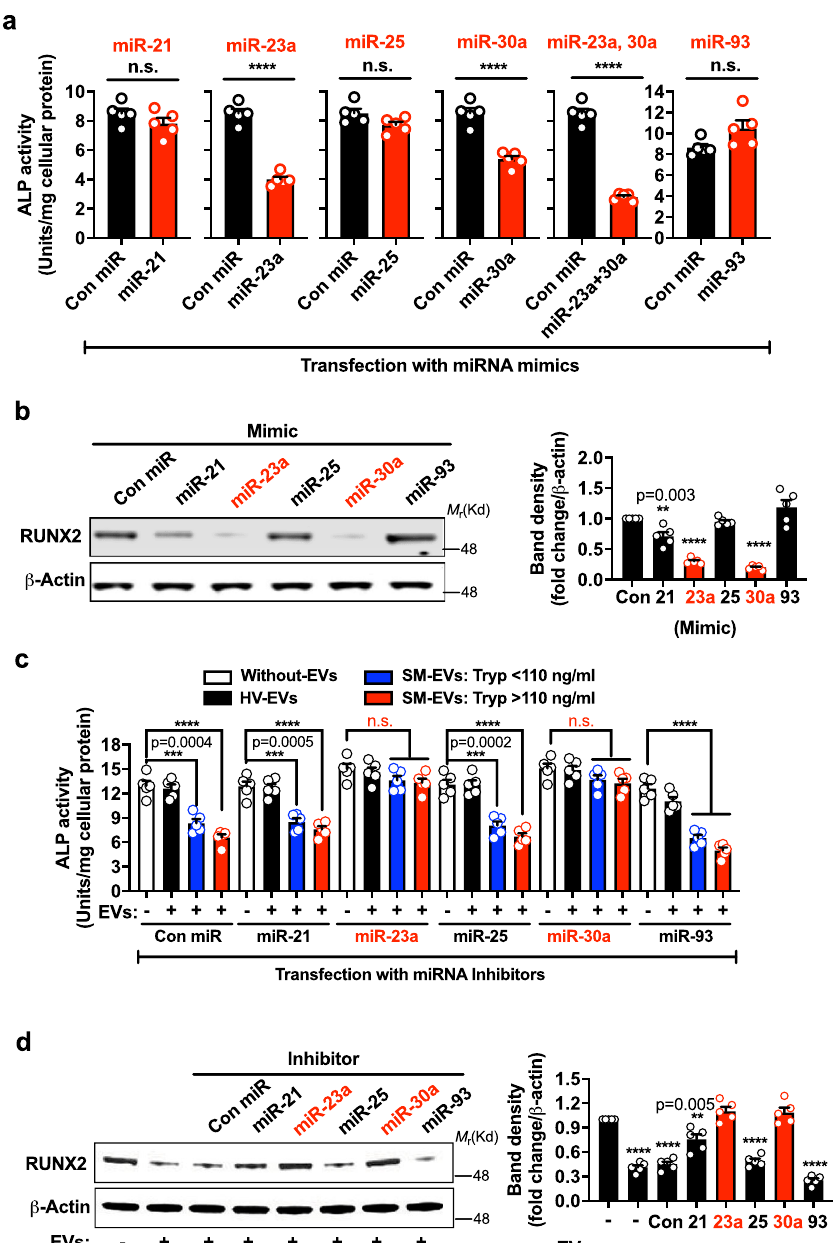
Fig. 5 miR-23a and miR-30a mediate inhibition of osteoblast differentiation induced by SM-EVs. a, b Effect of miRNA mimics on osteoblast differentiation. hFOB1.19 cells were plated and next day transfected with 100 nM of control (Con miR), miR-21, mR-23a, miR-25, miR-30a, or miR-93 mimics. After 2 days, the transfection media were replaced. Five days later, alkaline phosphatase (ALP) activity was determined in the culture media ( a ) and RUNX2 protein expression in cell lysates determined by Western blot ( b ). c, d Functional knockdown of miR-23a and miR-30a reverse the attenuating effects of extracellular vesicles isolated from the serum of patients with systemic mastocytois (SM-EVs) on osteoblast differentiation. hFOB1.19 cells were seeded and then treated or not (white bars are untreated cells) with pooled extracellular vesicles isolated from the serum of healthy volunteers (HV-EVs) (black bars), pooled SM-EVs from patients with serum tryptase values lower than 110 ng/mL (blue bars; SM-EV: Tryp < 110 ng/mL), or SM-EVs from patients with serum tryptase values >110 ng/mL (red bars; SM-EV: Tryp > 110 ng/mL), as described in “ Methods. ” Cells were then transfected with the miRNA inhibitors (inhib.) for 2 days. Transfection media were replaced and 5 days later, ALP activity was measured in the media ( c ) and RUNX2 expression in cells detected by Western blotting ( d ). In b and d , the bar graphs represent the relative fold changes in band intensity normalized to β -actin and compared to the respective controls ( fi rst bar). All data ( a – d ) represent the mean ± SEM ( n = 5 biological replicates) of representative experiments and repeated at least twice with similar results. In a – d , ** p < 0.01; *** p < 0.001; **** p < 0.0001; and n.s., not signi fi cant using an unpaired Student t -test (two-tailed) for the indicated comparisons or compared to the fi rst bar ( b , d ). The blots are representative images from one experiment.